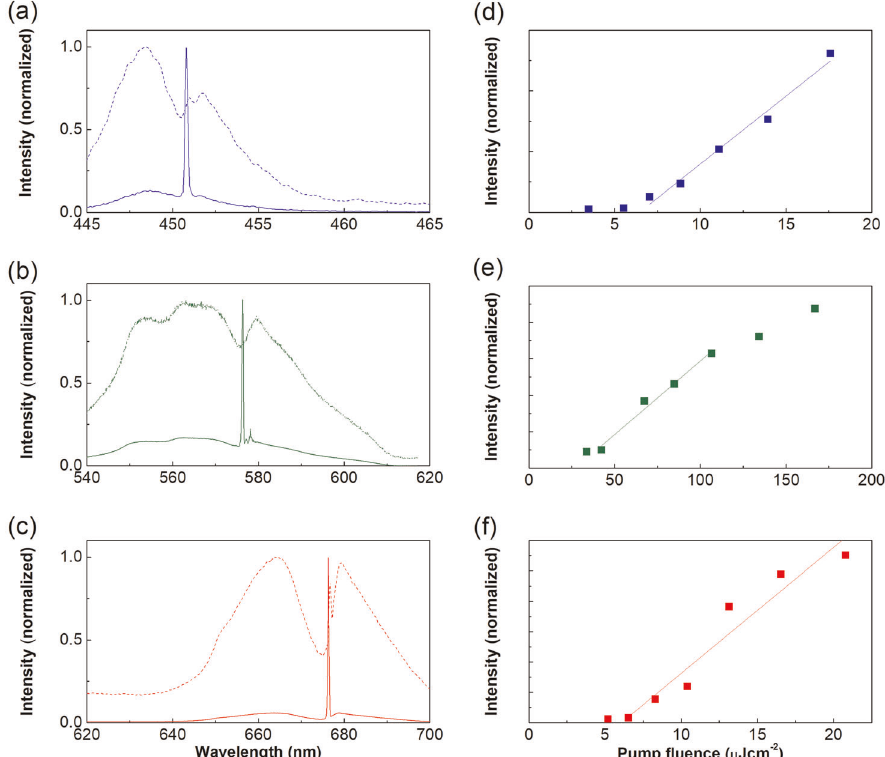
Fig. 5 Left column: Normalized intensity of a blue, b green – yellow, c red, emission from the CP DFB lasers below the threshold (dashed lines) and just above the threshold (solid lines). Right column: Variation of the output laser power as a function of pump fl uence in d blue, e green – yellow, and f red emitting DFB structures. The red, green, and blue solid lines represent linear fi ts above the thresholds